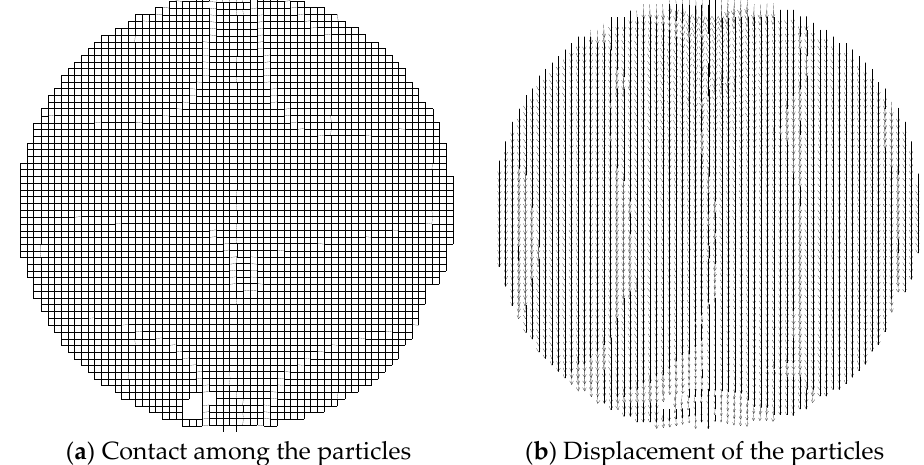
Figure 8. Model at early loading stage.